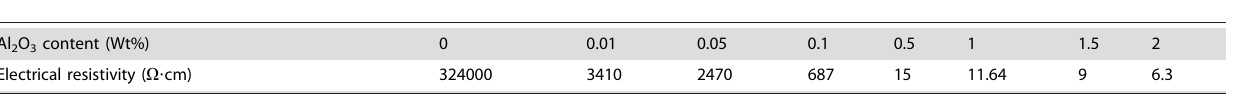
Table 1. The electrical resistivity of ZnO/Al 2 O 3 ceramic with different Al 2 O 3 content.